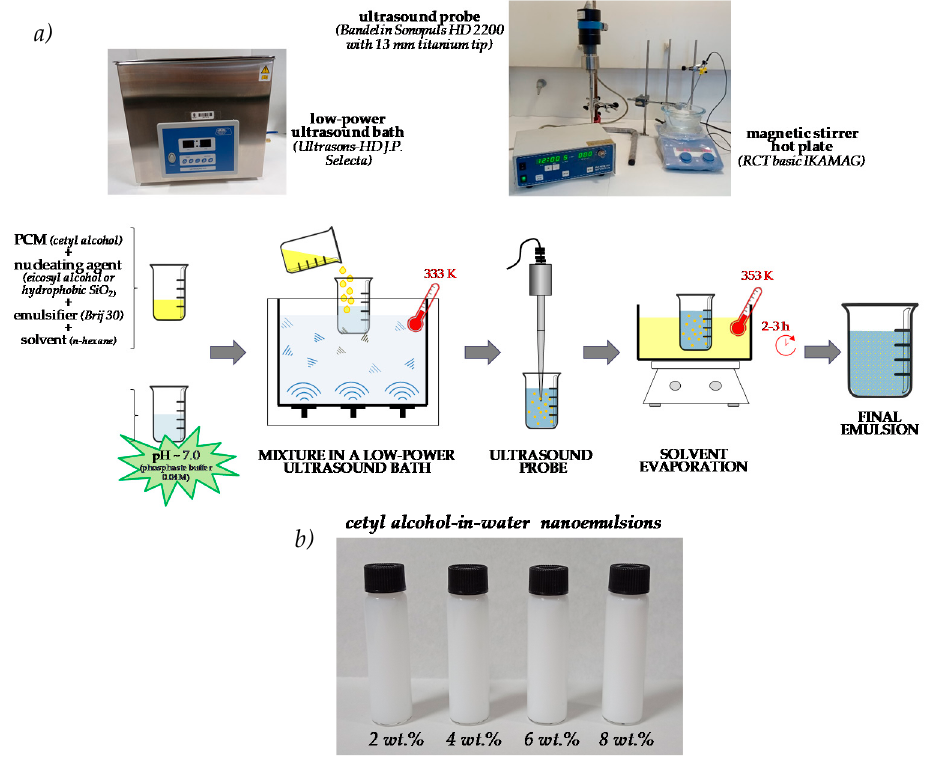
Figure 1. ( a ) Major steps of the solvent-assisted method used for the formulation of cetyl alcohol-in- water nanoemulsions, and ( b ) images of prepared fatty alcohol-in-water nanoemulsions containing 2, 4, 6 and 8 wt.% of dispersed phase without a nucleating agent.